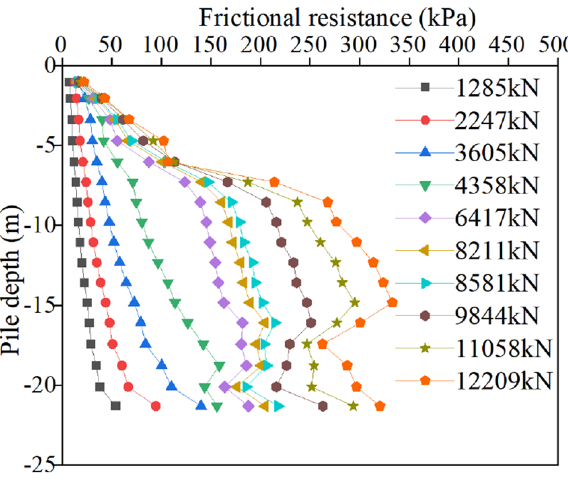
Figure 10. Friction resistance of the bottom uplift